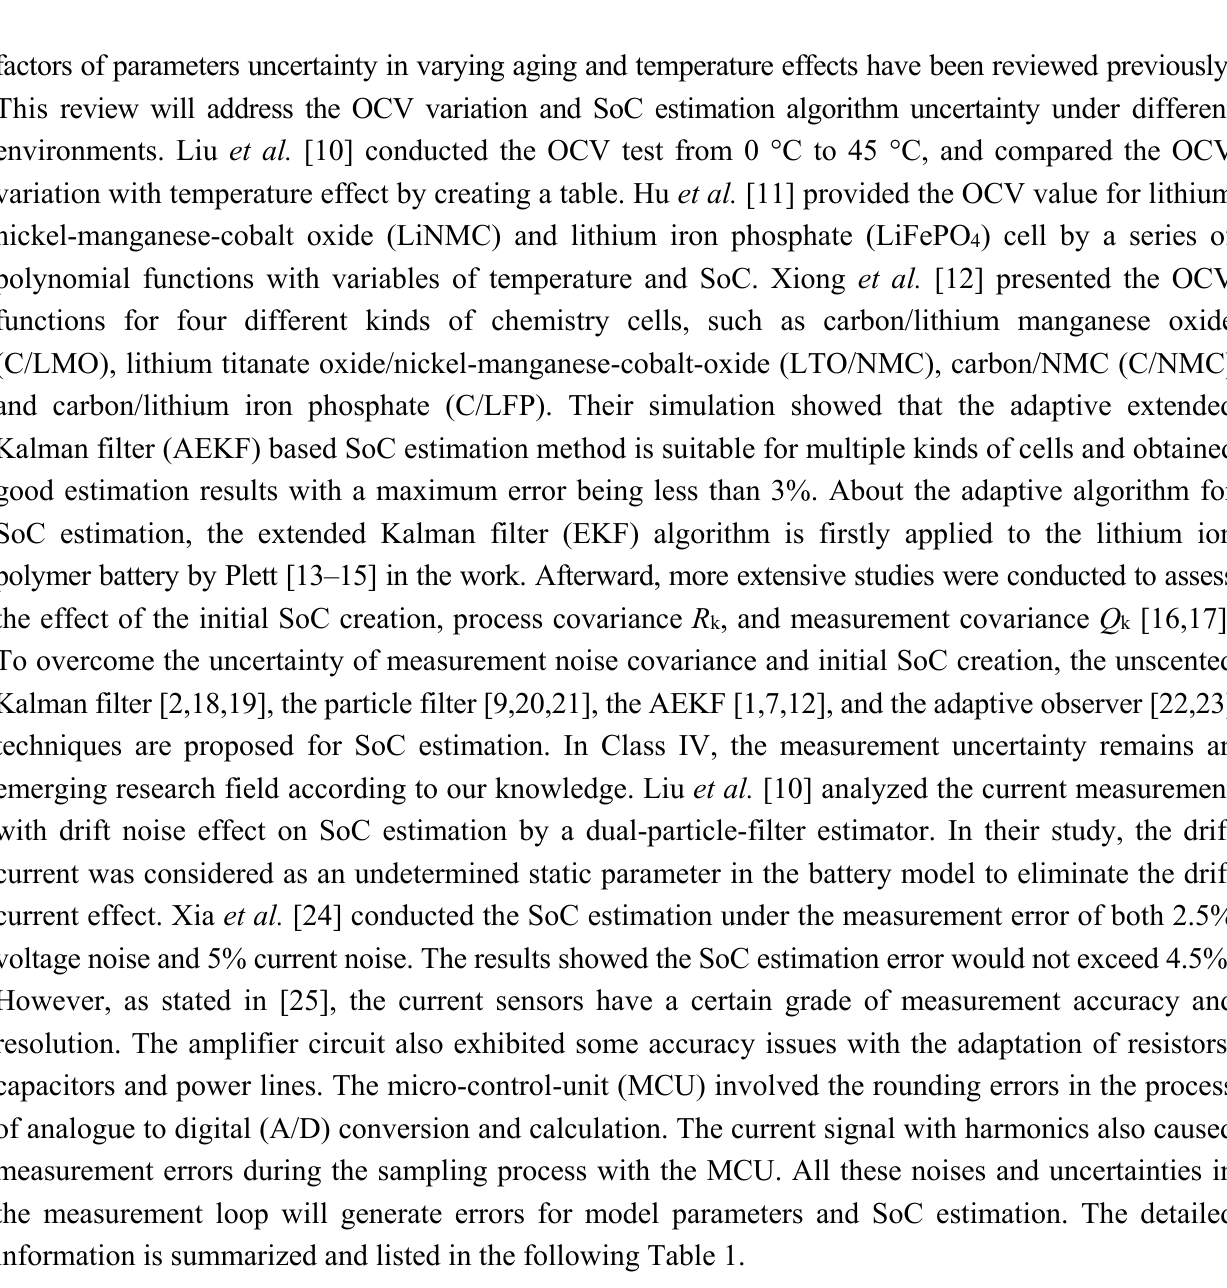
Table 1. Factors influencing on the model parameters and state of charge (SoC) estimation.